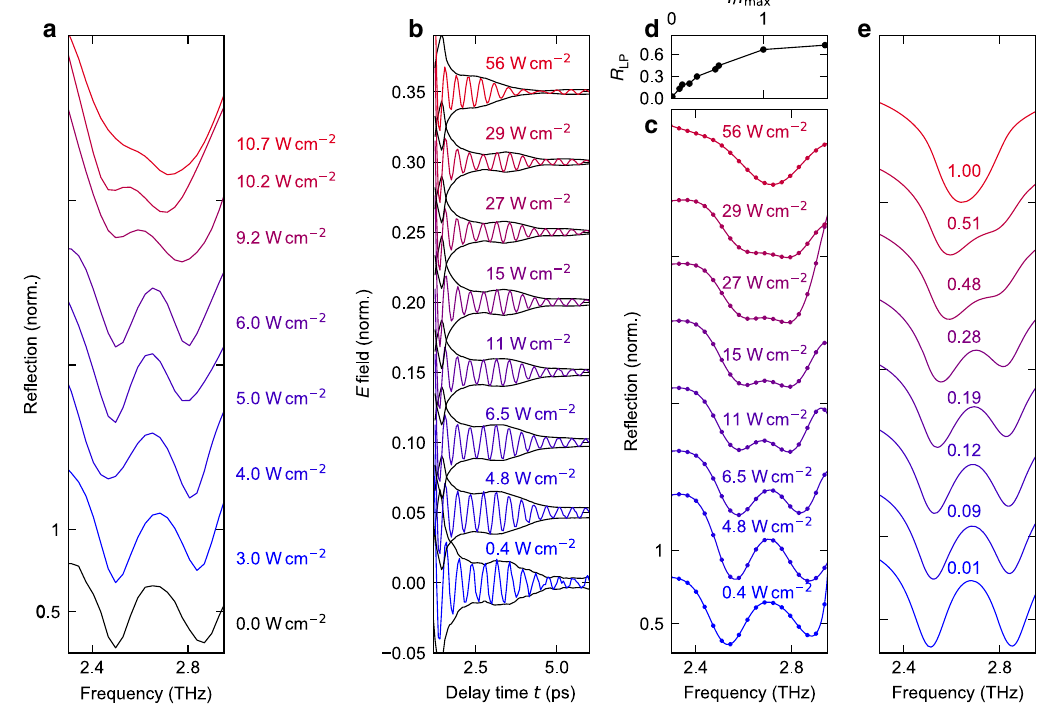
Fig. 2 Saturation of re fl ectivity for high pump intensities. a Experimental re fl ection spectra measured by FTIR during cw excitation at a frequency of 2.75 THz and a peak intensity of up to 11 W cm − 2 . b Trailing emitted electric fi eld after excitation with an intense single-cycle THz waveform at a delay time t = 0 ps, for various peak intensities. The waveforms are vertically offset for clarity. The envelopes of the electric fi eld are shown as black curves. c Corresponding re fl ectivity spectra, vertically offset for clarity. d Re fl ectivity R LP at the frequency of the lower polariton, ν LP = 2.53 THz, as a function of the normalized intensity I / I max . e Simulated re fl ection spectra, calculated with a semiclassical approach (see text and “ Methods ” section) for various peak intensities, given as fractions of the saturation